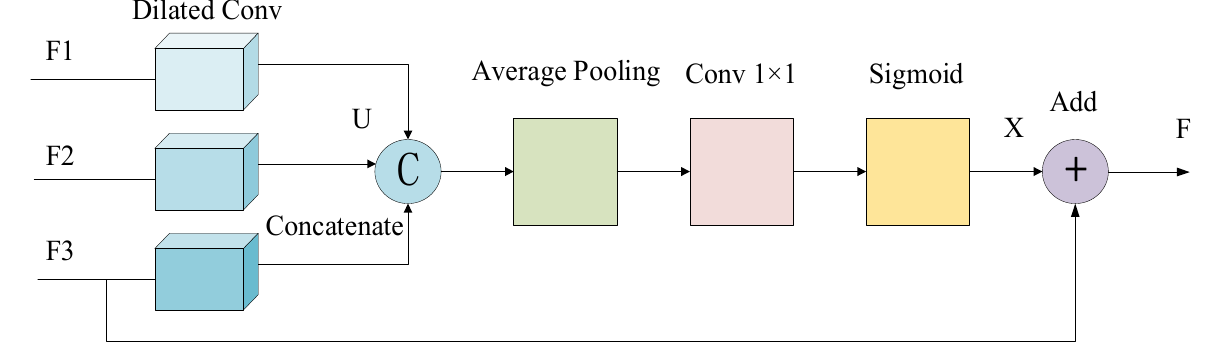
Figure 4. Scalable attention mechanism.